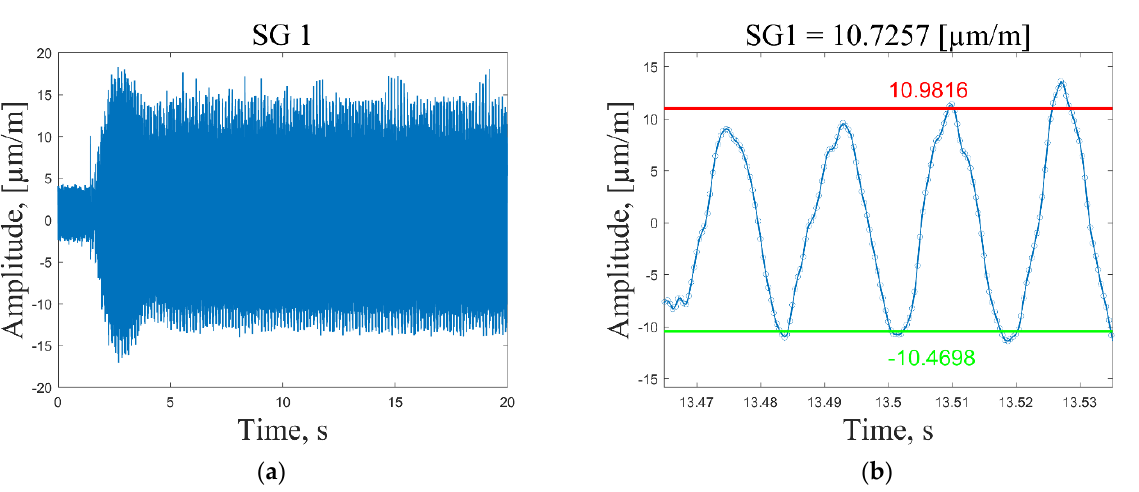
Figure 12. Recorded time series of strain response of the plate excited by a periodic sine wave signal corresponding to the first resonant frequency with a 1 V peak-to-peak vibration amplitude ( a ); cal- culated average peak-to-peak values for strain gauge 8 ( b ).